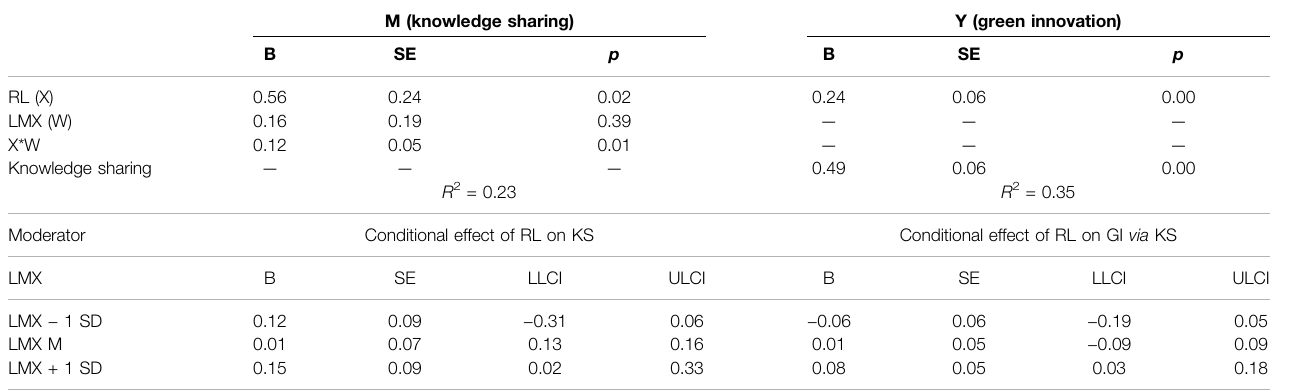
TABLE 5 | Regression coef fi cients and conditional indirect effect estimates.